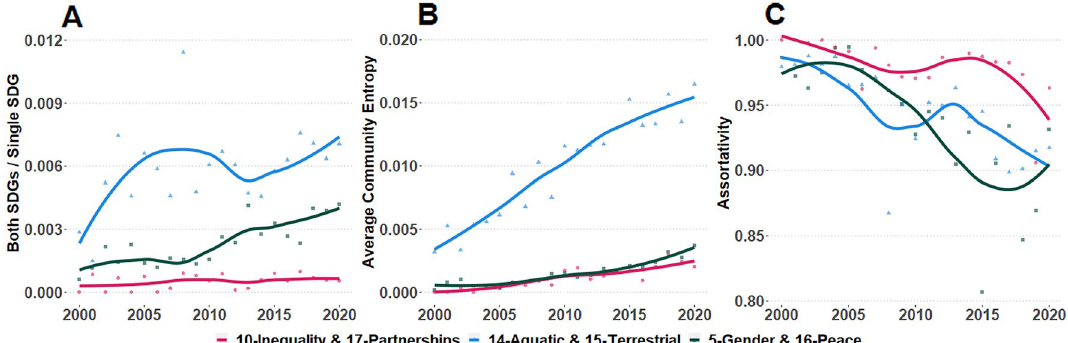
Figure 3. Integration and collaboration between scientists conducting SDG-related research in the three SDGs pairs with strongest interconnection in UN discourse (2000–2020). (A) Proportion of scientists working on both SDGs relative to those working on either SDG. (B) Entropy of Louvain communities by scientist SDG designation in coauthorship networks. (C) Assortativity index by scientist SDG designation in